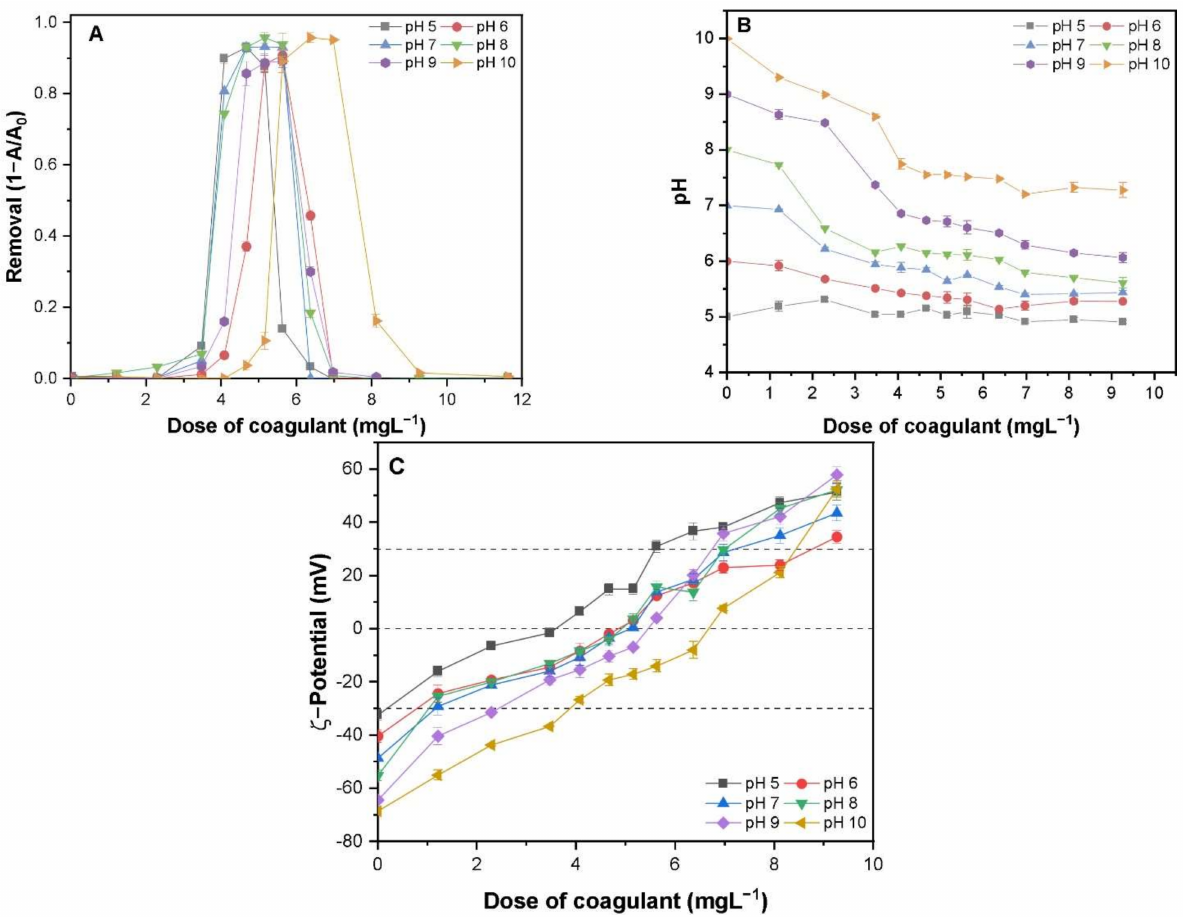
Figure 4. Effect of various PAFC dosages and solution pH on ( A ) removal efficiency; ( B ) final pH of suspension, and ( C ) ζ -potential of TA-CuO